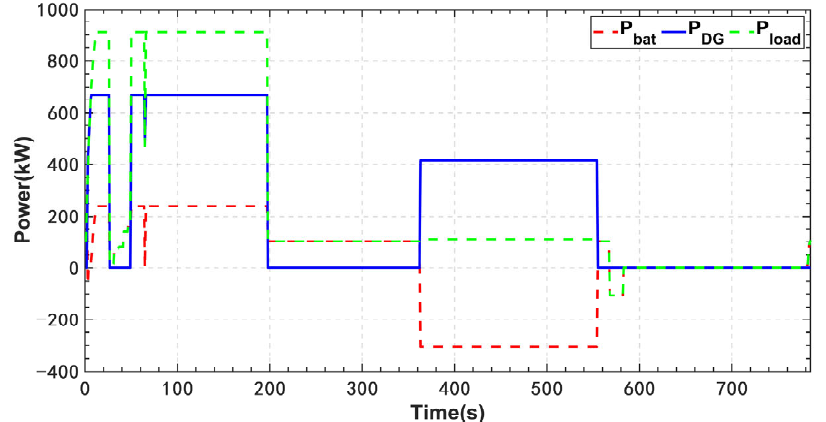
Figure 12. Power distribution diagram based on DP strategy.